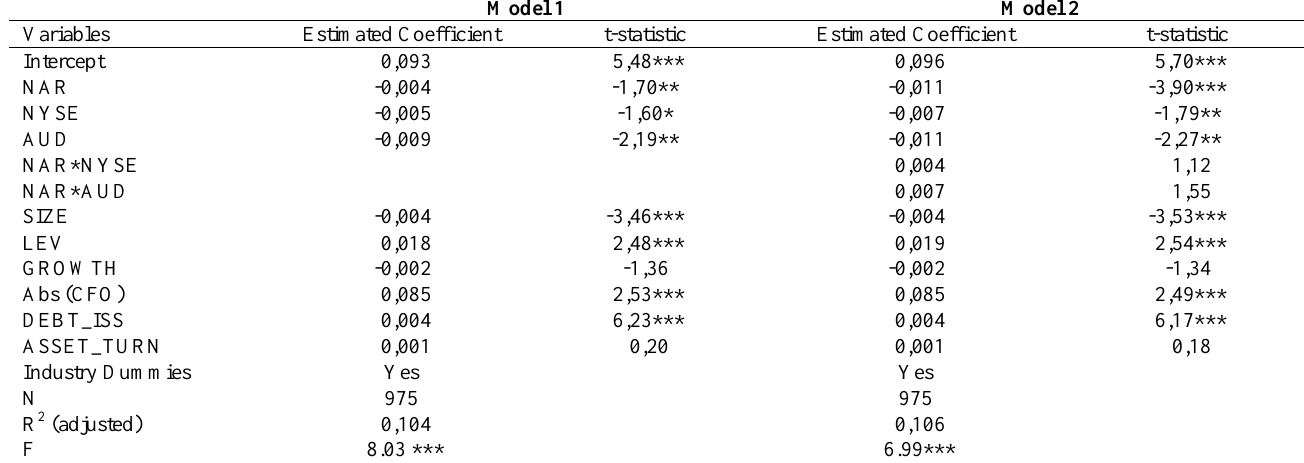
Table 8: Regressions of absolute discretionary accruals on independent variables and control variables. Jones Model (sensitivity test)